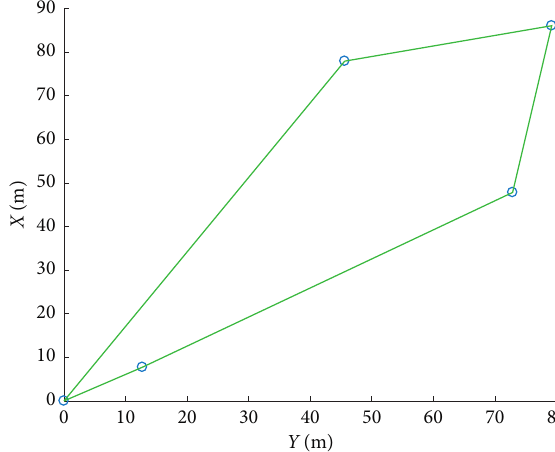
Figure 13: Planned trajectory at the beginning of the third subcycle.